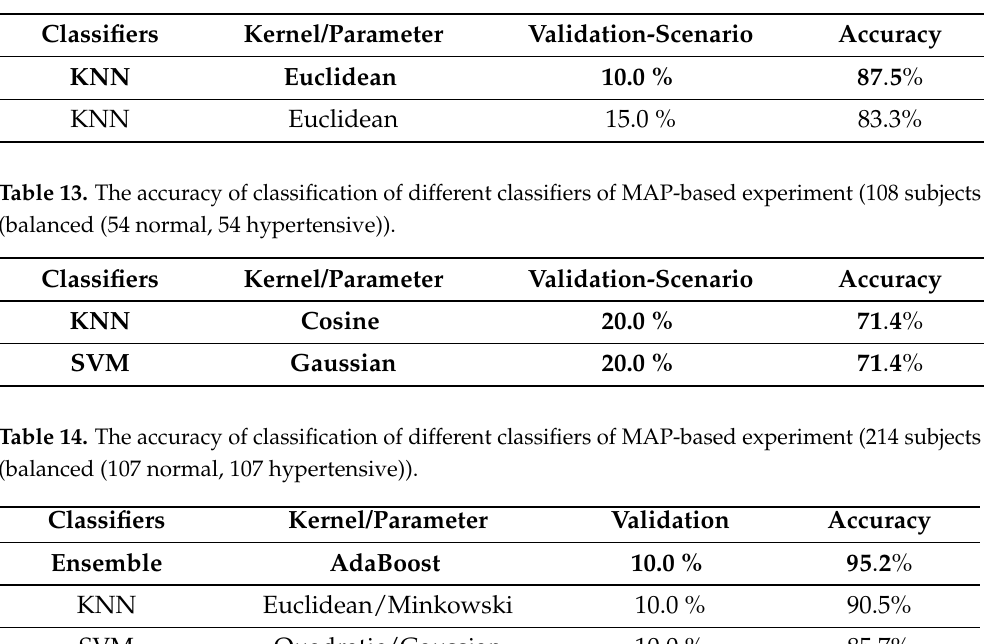
Table 12. The accuracy of classification of different classifiers of MAP-based experiment (161 subjects (107 normal, 54 hypertensive)).